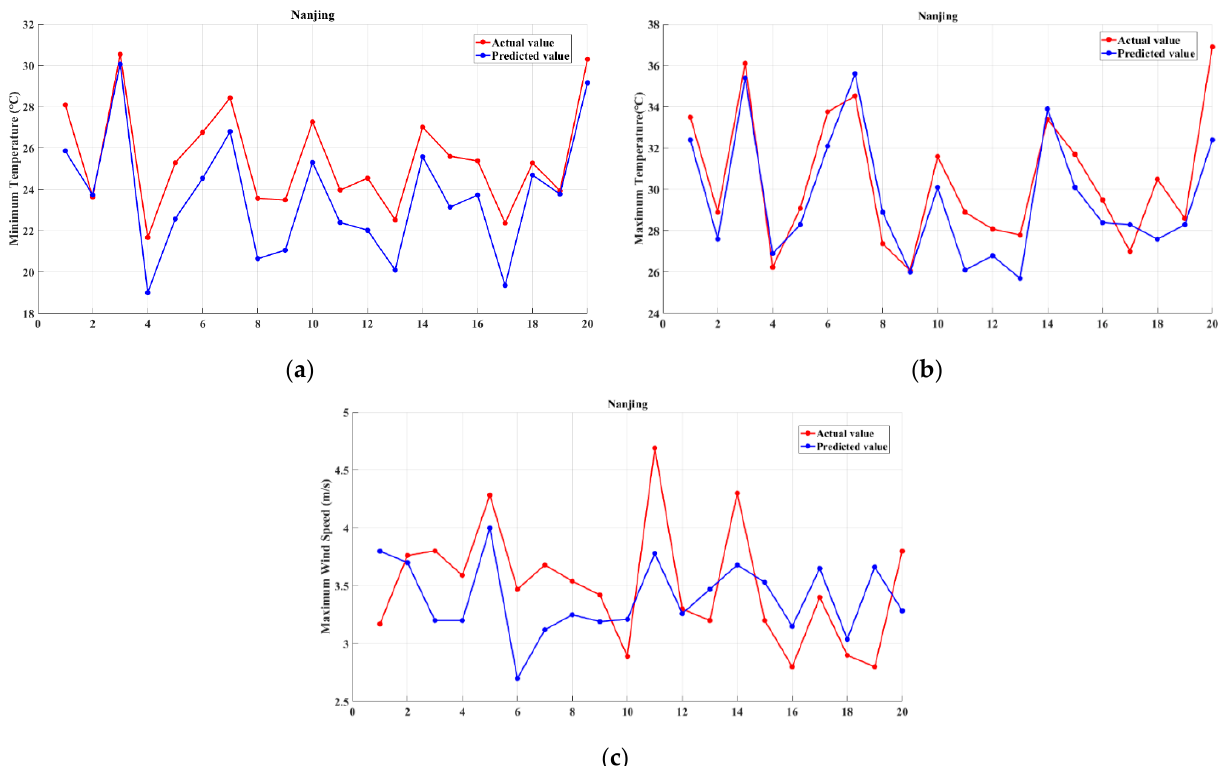
T , ( b ) T and ( c ) W . max min max